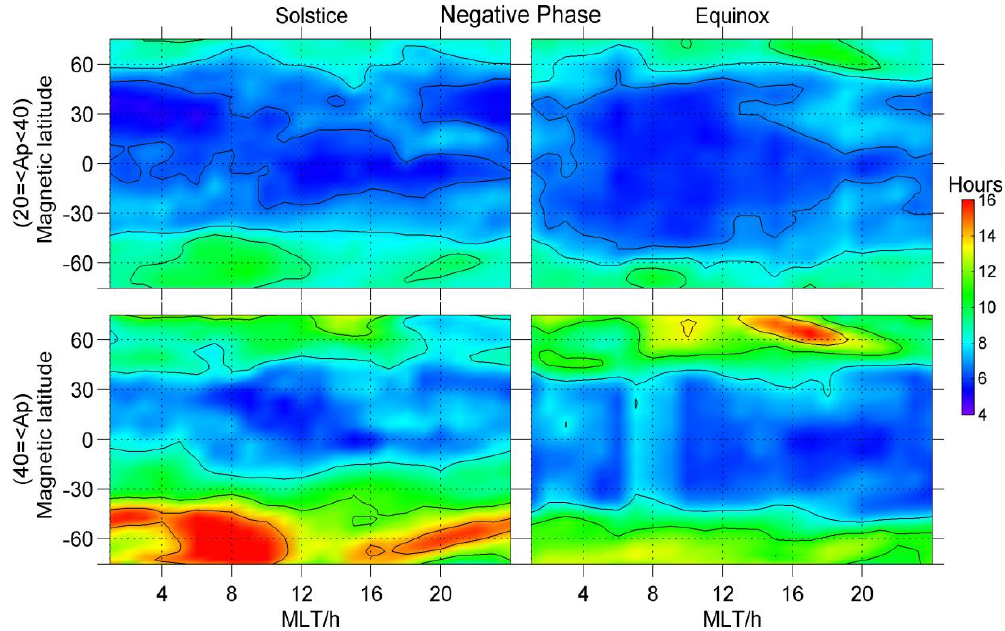
Fig. 5. Global distribution of the mean time duration related to negative ionospheric storms in the MLAT vs. MLT frame for solsticial months (left panels) and equinoctial months (right panels). The Northern Hemisphere of left panels locates in winter and the Southern Hemisphere corresponds to the summer months.